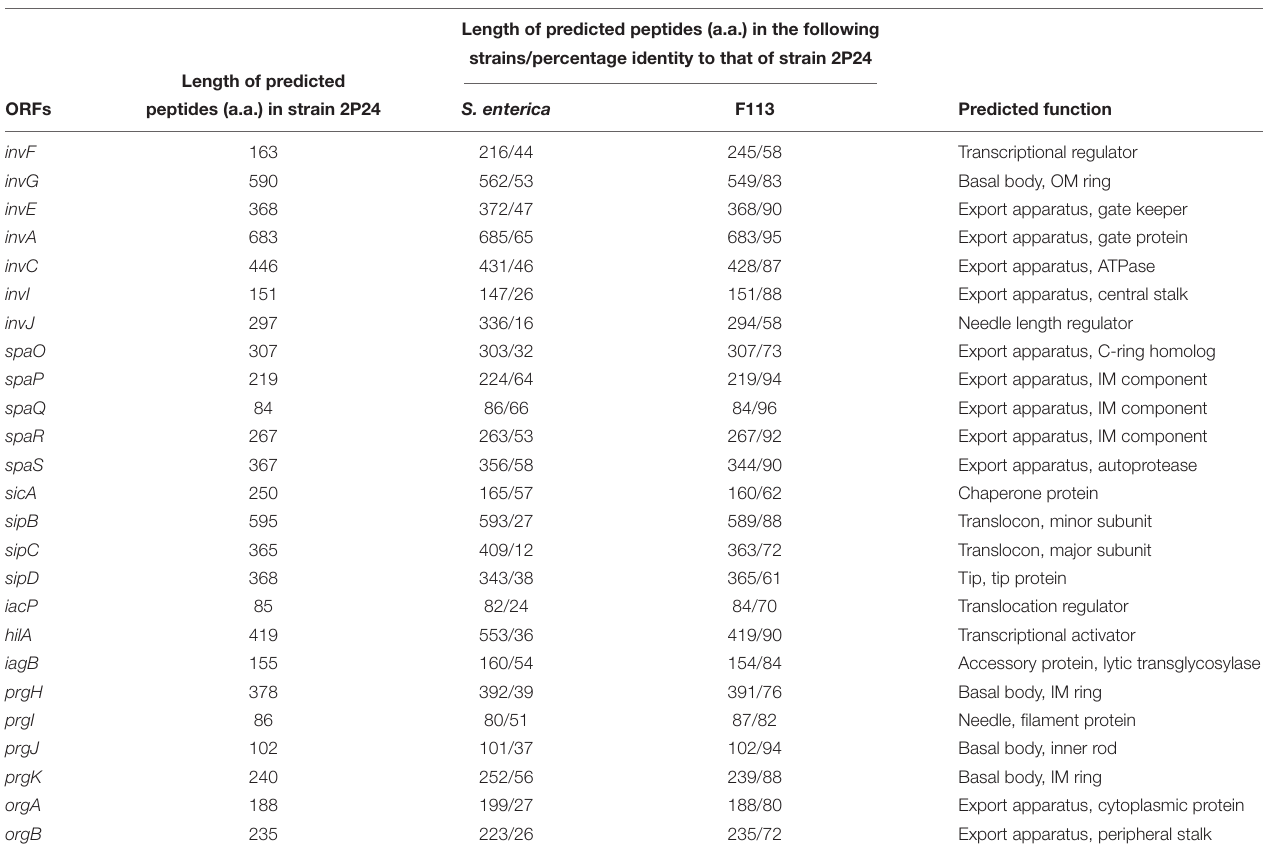
( Figure 4A and Supplementary Table 1 ). KEGG analyses indicated that DEGs at 6 h and 12 h involved biosynthesis of secondary metabolites, biosynthesis of amino acids,